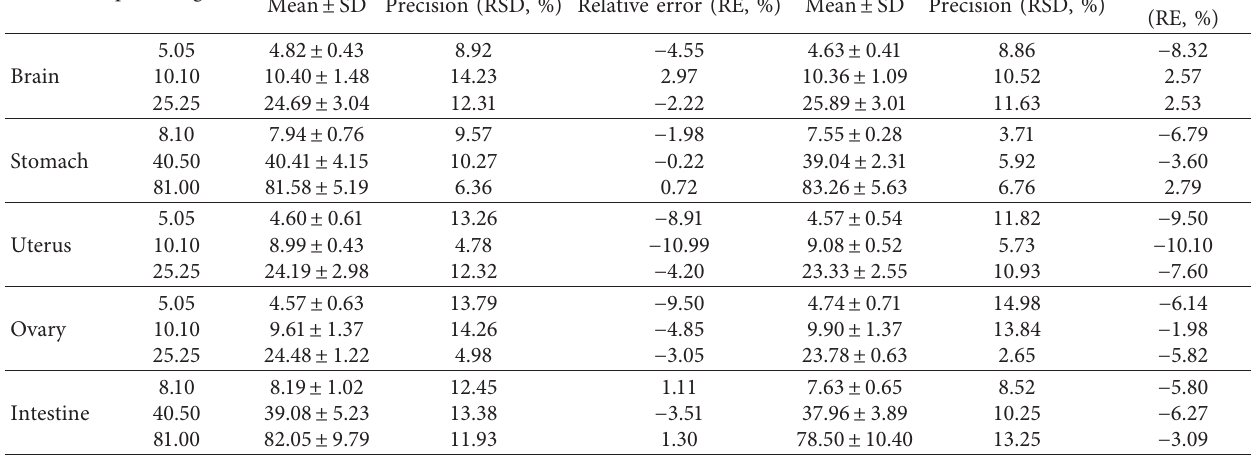
Tissues Spiked (ng/mL)